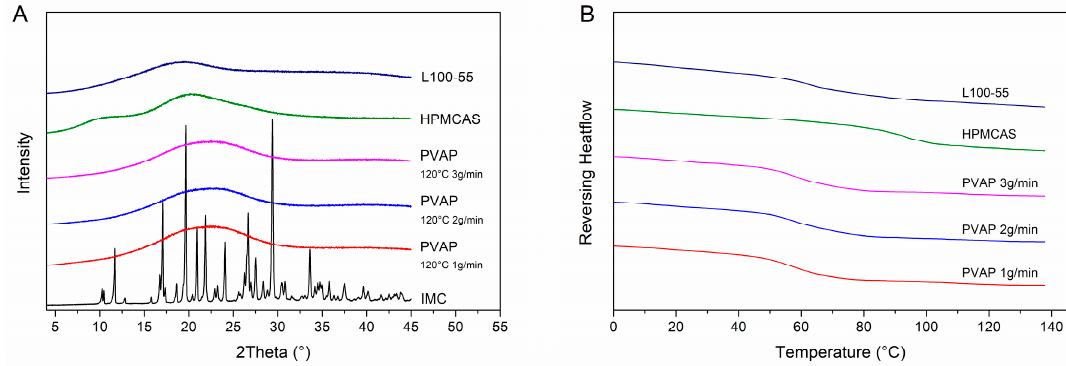
Figure 7. Solid-state of the drug-containing ASDs. X-ray powder di ff raction (XRPD) di ff ractograms ( A ). Di ff erential scanning calorimetry (DSC) thermograms ( B ).